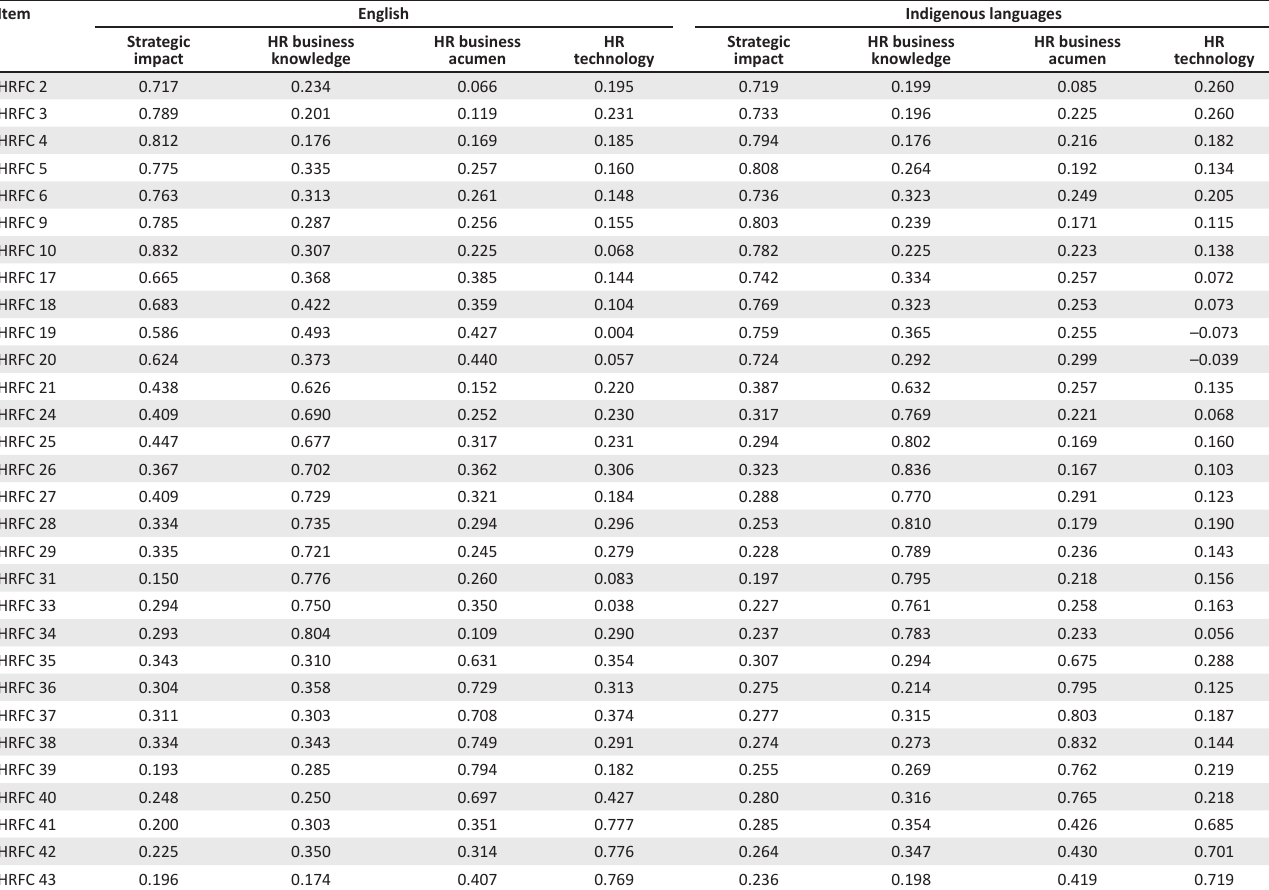
TABLE 3: Rotated component matrix for the business intelligence dimension. Item